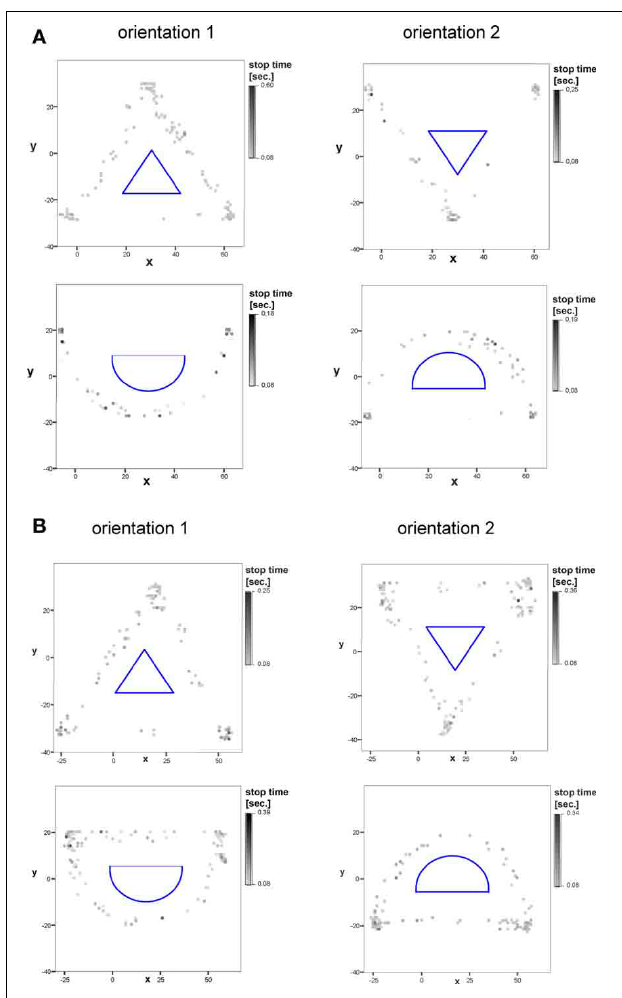
FIGURE 5 | Example of the allocation and xy-position of explorative stops of two stimuli in the virtual (A), and real (B) test condition in orientation 1 and orientation 2 (10 subjects). The duration of explorative stops is marked in different grayscales. The stimulus structure is displayed in the middle